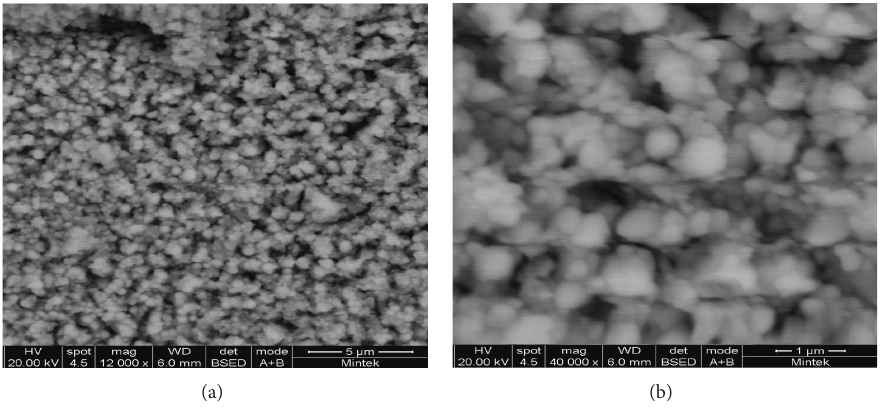
Figure 3: SEM image of 1% AZO film (a) with magnification × 12000 and (b) with magnification × 40000.